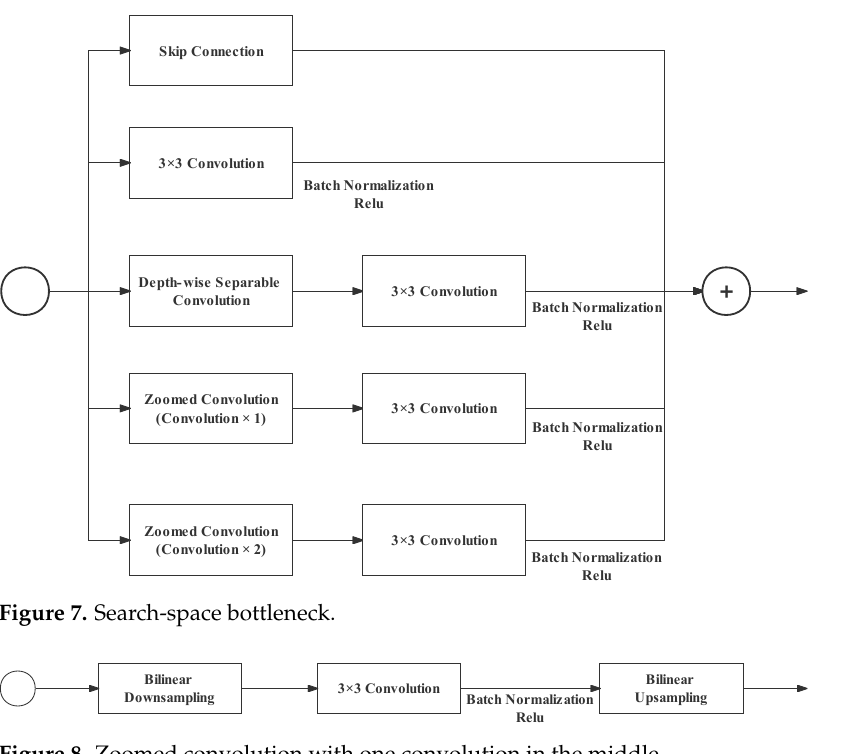
Figure 8. Zoomed convolution with one convolution in the